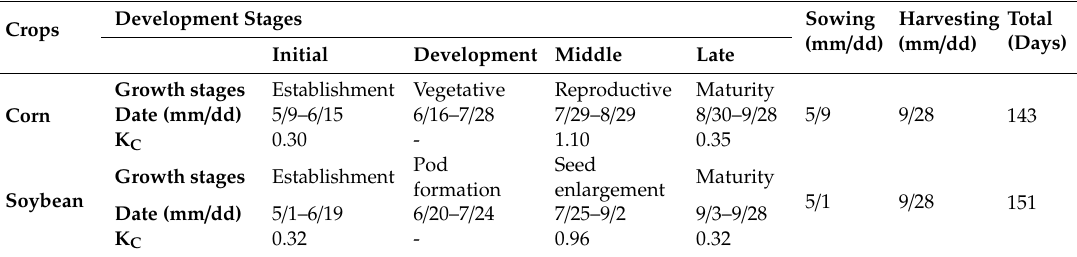
Table 1. Crop coe ffi cient and development stages.